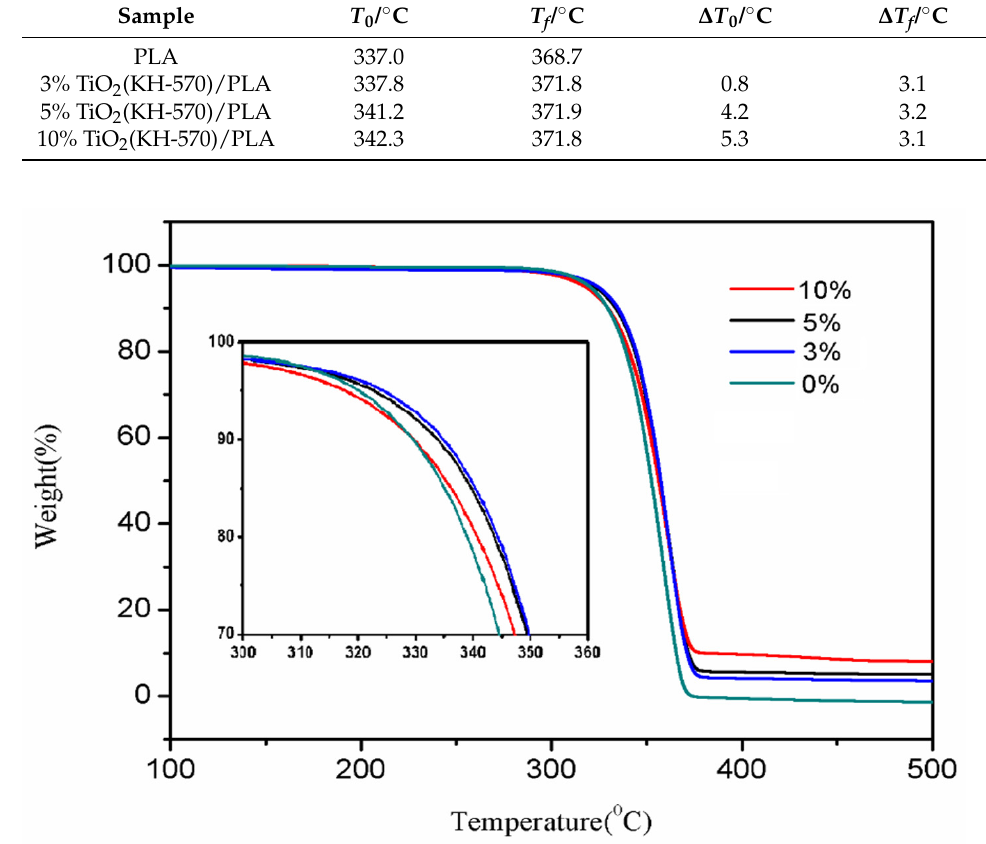
Figure 8. The effect of TiO 2 content on thermal stability.